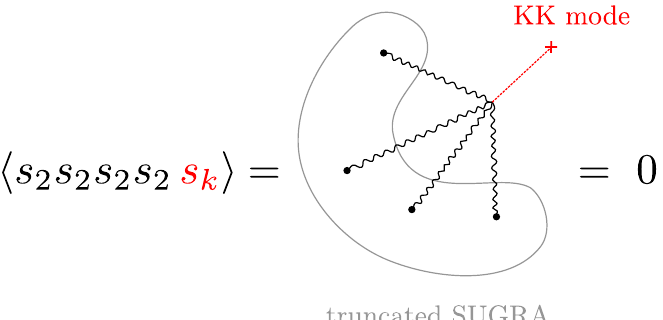
Figure 3: Relation between the vanishing of near-extremal correlation functions and the consistent truncation of supergravity. For k becomes equivalent to a physical requirement that the modes in the truncated super- gravity do not source a higher Kaluza-Klein mode [ 29 ] . This is a necessary condition for the existence of the consistent truncation of type IIB supergravity on AdS